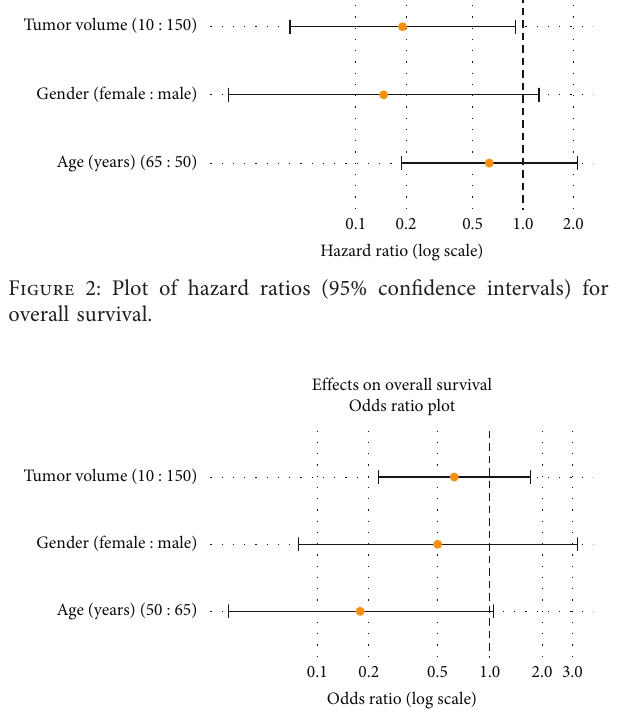
Figure 3: Plot of the odds ratios (95% confidence intervals) re- garding tumor stability (tumor stability refers to stable disease RECIST 1.1, and compared to partial remission, it is referred to as an undesired